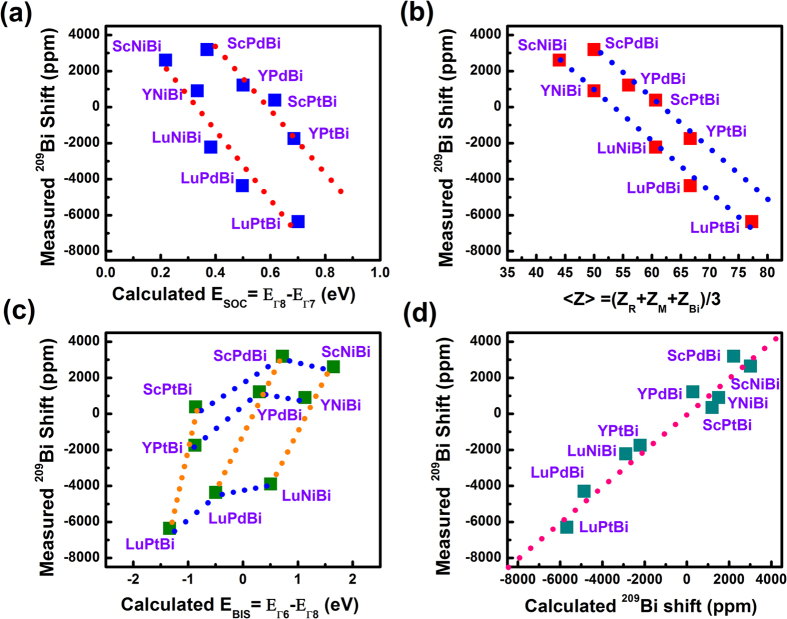
Scaling of 209Bi isotropic shifts.The measured NMR 209Bi isotropic shifts as a function of (a) the calculated SOC parameter ESOC, (b) the average nuclear charge <Z> (=(ZR + ZM + ZBi)/3), (c) the calculated band inversion strength EBIS and (d) the calculated NMR 209Bi isotropic shifts.